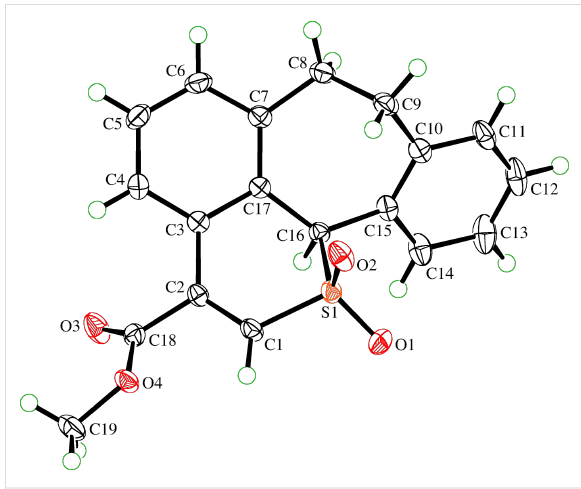
Figure 2: ORTEP Plot [19] of the molecular structure of one of the symmetry-independent molecules of 6d , drawn using 50% probability displacement